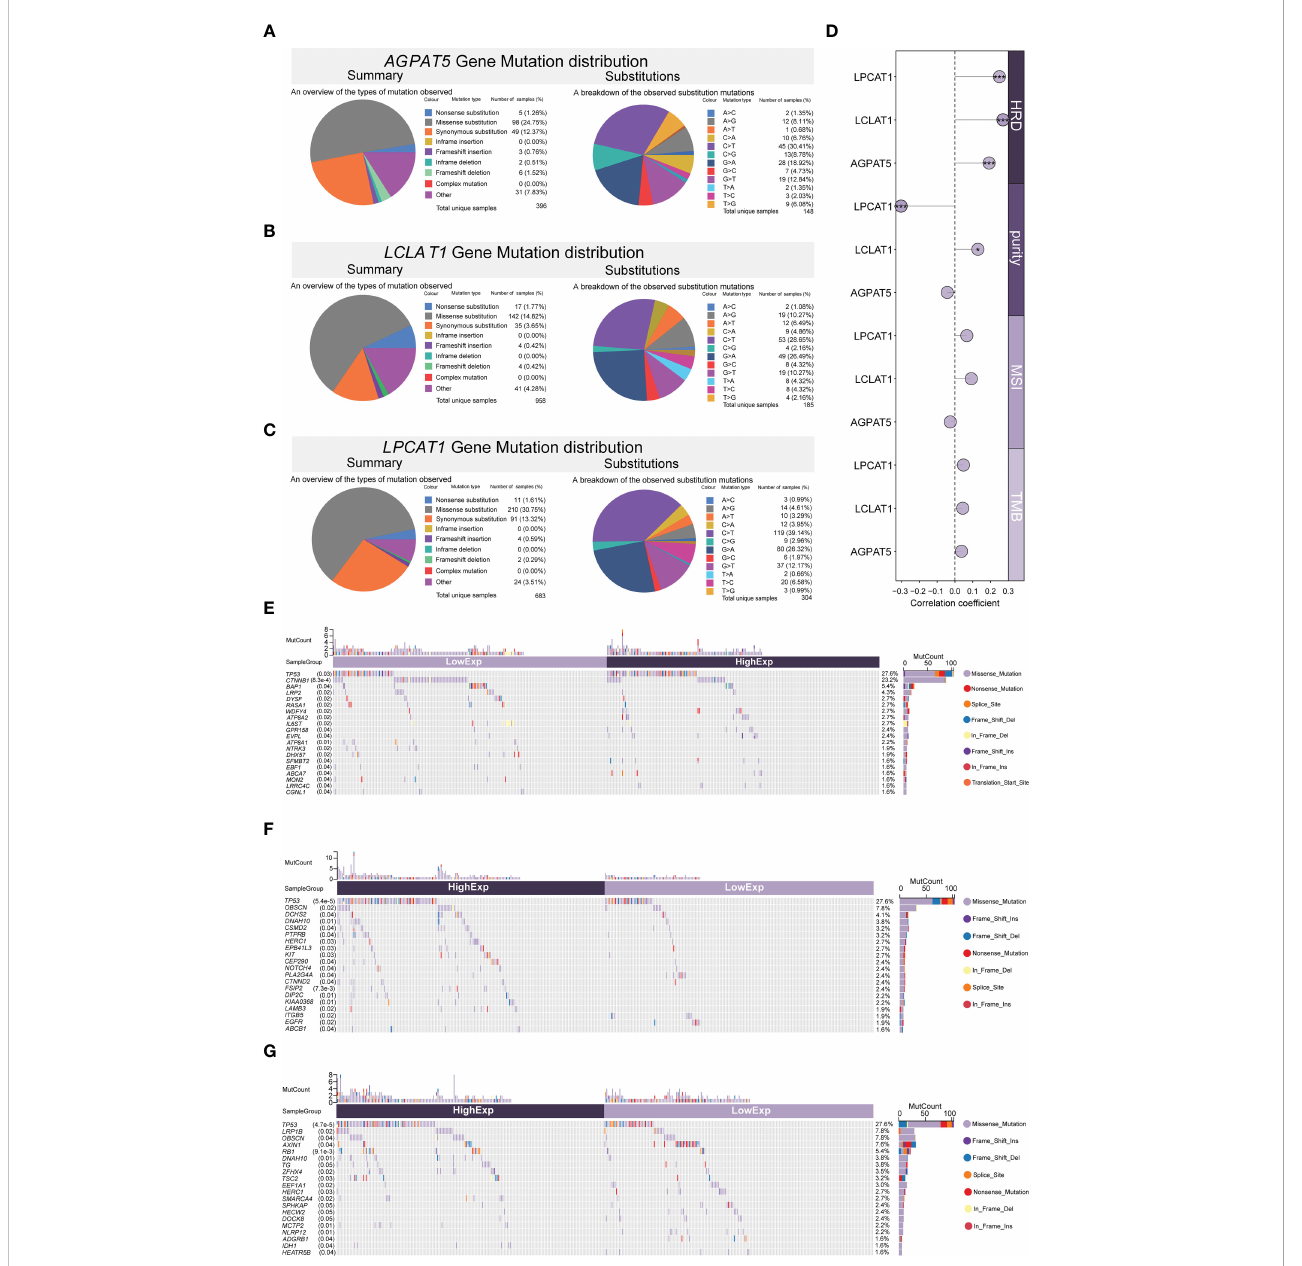
FIGURE 6 Mutations of genes ( AGPAT5 , LCLAT1 , and LPCAT1 ) in HCC. (A – C) Evaluation of AGPAT5 (A) , LCLAT1 (B) , and LPCAT1 (C) mutation types (COSMIC database). (D) Pearson correlations between genomic heterogeneity indicators with gene expression. (E – G) Differences in the somatic mutation landscape between high- and low-gene-expression ( AGPAT5 , LCLAT1 , and LPCAT1 , respectively) groups. Signi fi cance signs: *p< 0.05; **p< 0.01; ***p<